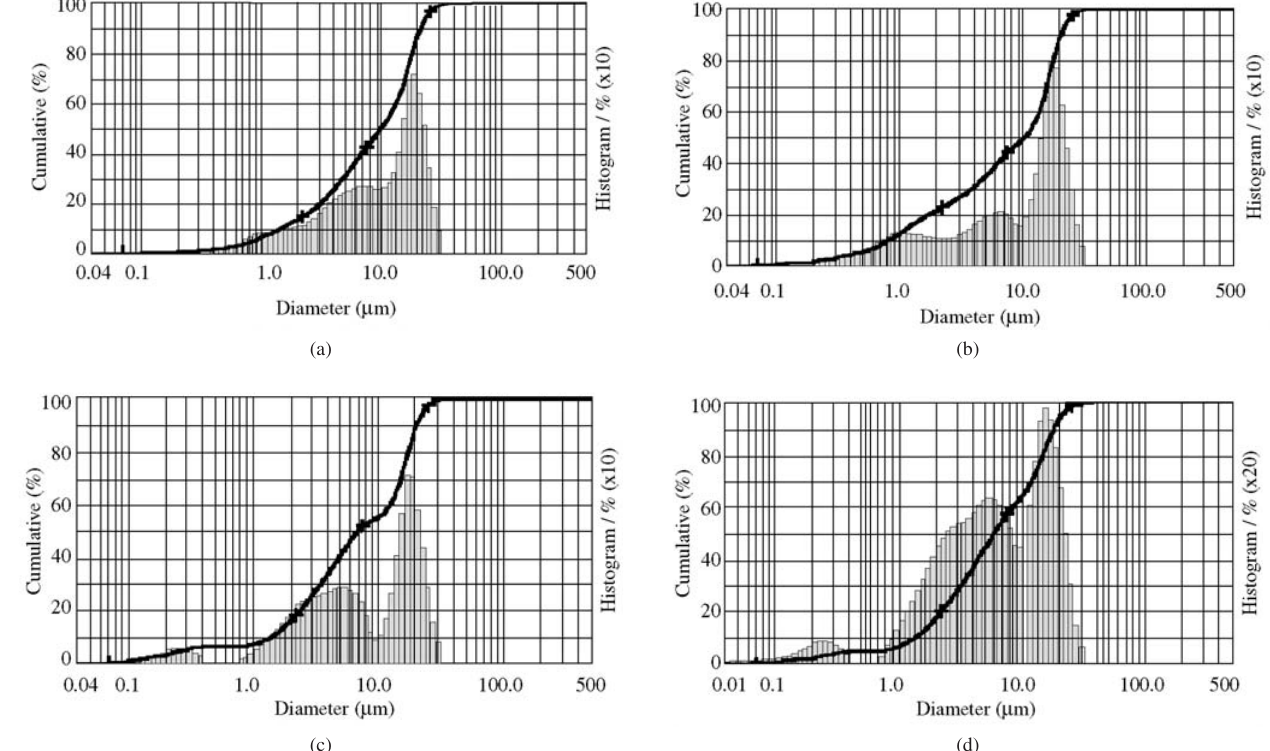
Figure 3. Particle size distribution of powders calcined at: a) 500 (cid:111) C; b) 700 (cid:111) C; c) 900 °C for 4 hours; d) 900 (cid:111) C for 8